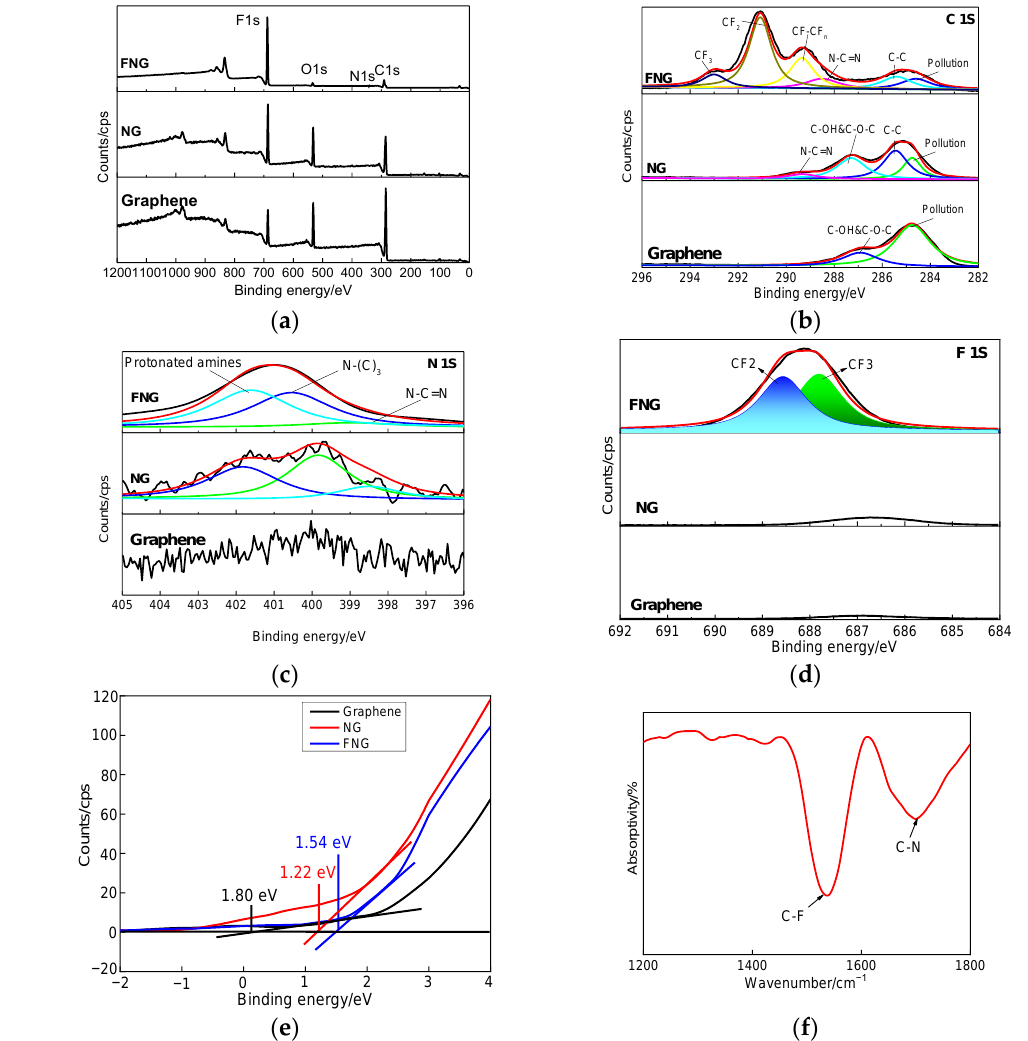
Figure 5. XPS and FTIR analysis of the obtained films: ( a ) XPS survey spectra, ( b ) C1s spectra, ( c ) N1s spectra, ( d ) F1s spectra, ( e ) valence band spectrum, ( f ) FTIR spectra.